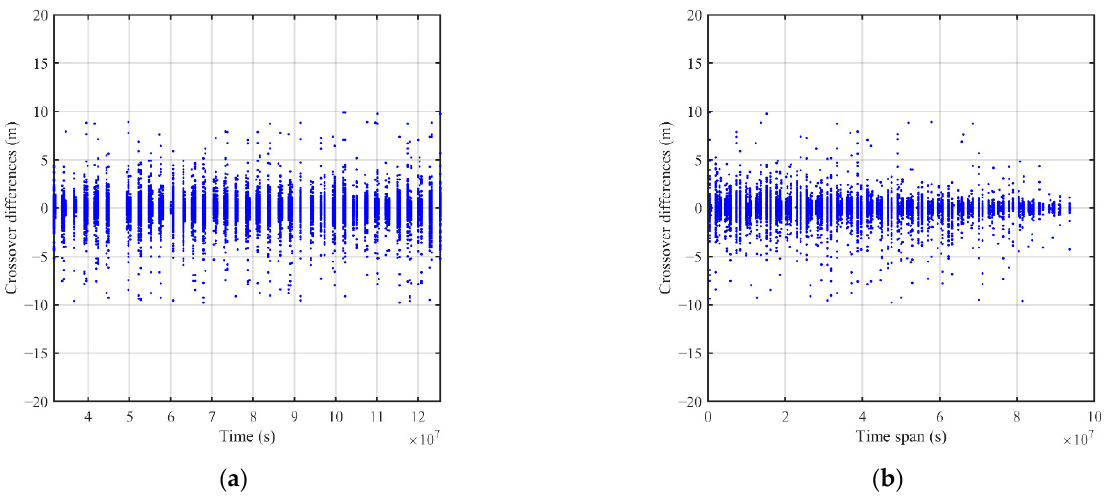
Figure 6. The distribution of crossover differences over time. ( a ) The variation of crossover differences with absolute observation time; ( b ) the variation of the crossover differences with time